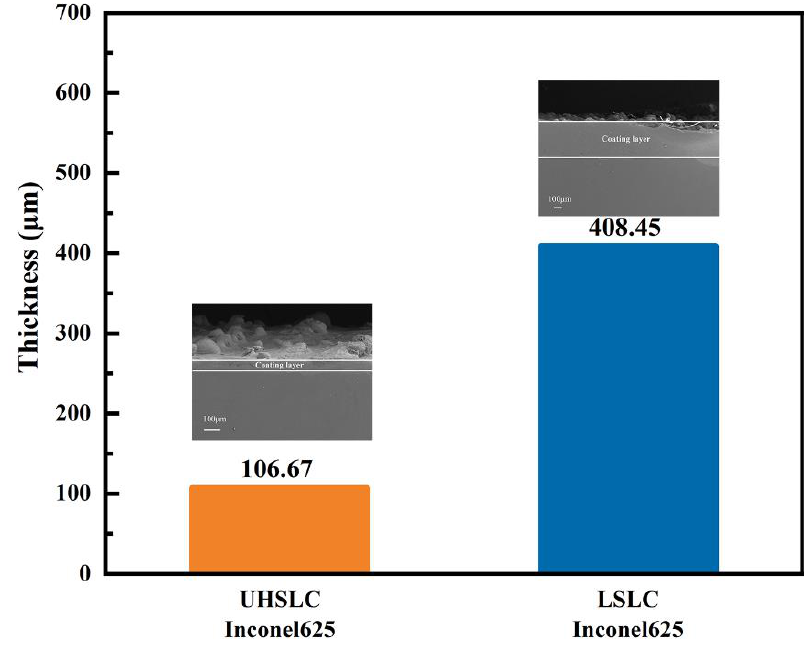
Figure 7. The thickness of Inconel625 alloys coatings prepared by UHSLC and LSLC.